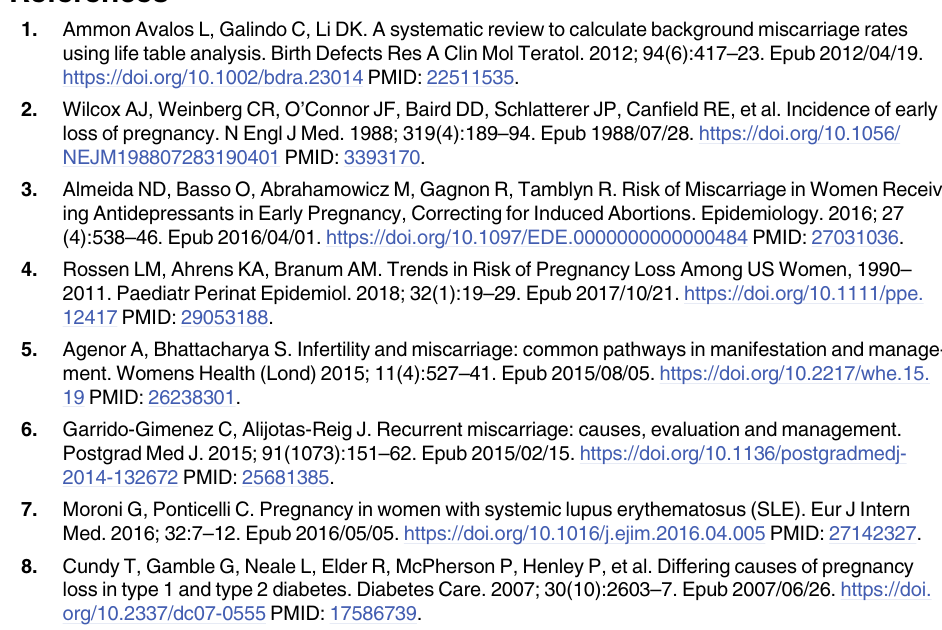
S4 Fig. Age-associated risk of miscarriage identified in specialist ( n = 62,974 pregnancies) or primary ( n = 22,702 pregnancies) healthcare services. S5 Fig. Adjusted odds ratios of miscarriage according to the presence of chronic conditions prior to pregnancy according to whether the miscarriage was identified in the specialist ( n = 62,974 pregnancies) or primary healthcare ( n = 22,702 pregnancies). S6 Fig. Adjusted odds ratios of miscarriage according to the presence of chronic conditions prior to pregnancy mutually adjusting for other chronic